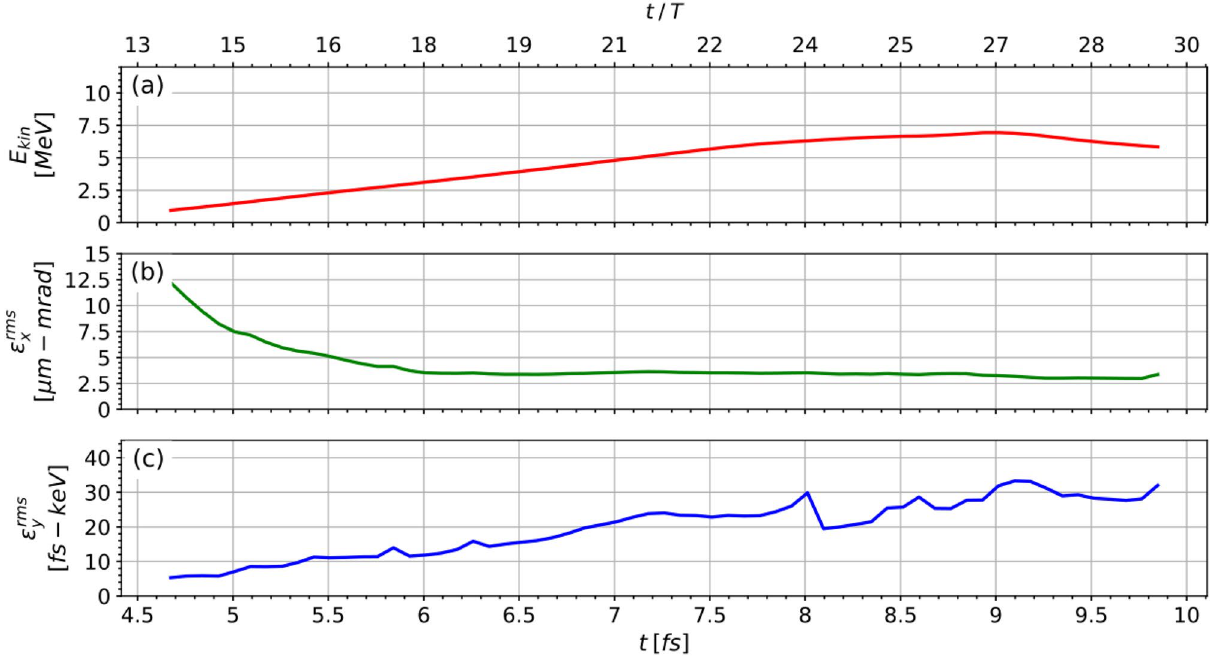
Figure 5. Evolution of key bunch parameters: ( a ) mean kinetic energy, ( b ) transverse emittance, ( c ) longitudinal emittance.